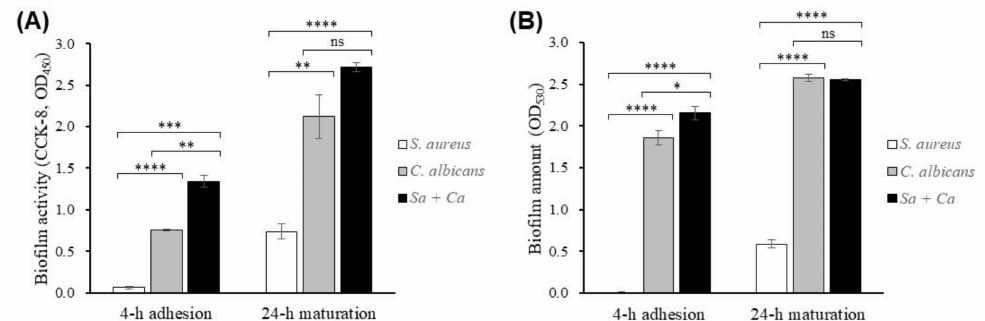
Figure 1. Analysis of in vitro microbial biofilm with C. albicans and S. aureus . Using microplates or hydrophilic membrane filters as an adherent surface, 10 5 cfu of C. albicans and/or S. aureus strains were seeded for 4-h adhesion and 24-h maturation of biofilms at 37 ◦ C and analyzed using a CCK-8 kit ( A ) or Gram’s safranin dye staining ( B ). Note: * p < 0.05, ** p < 0.01, *** p < 0.001, **** p < 0.0001, ns = not